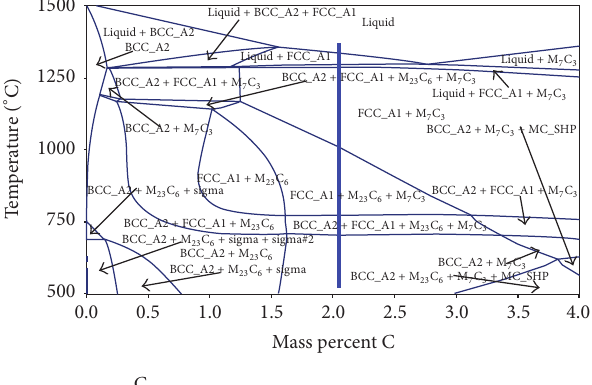
Figure 3: Equilibrium phase of the HCCI calculated by Thermo-Calc software based on TCFE7